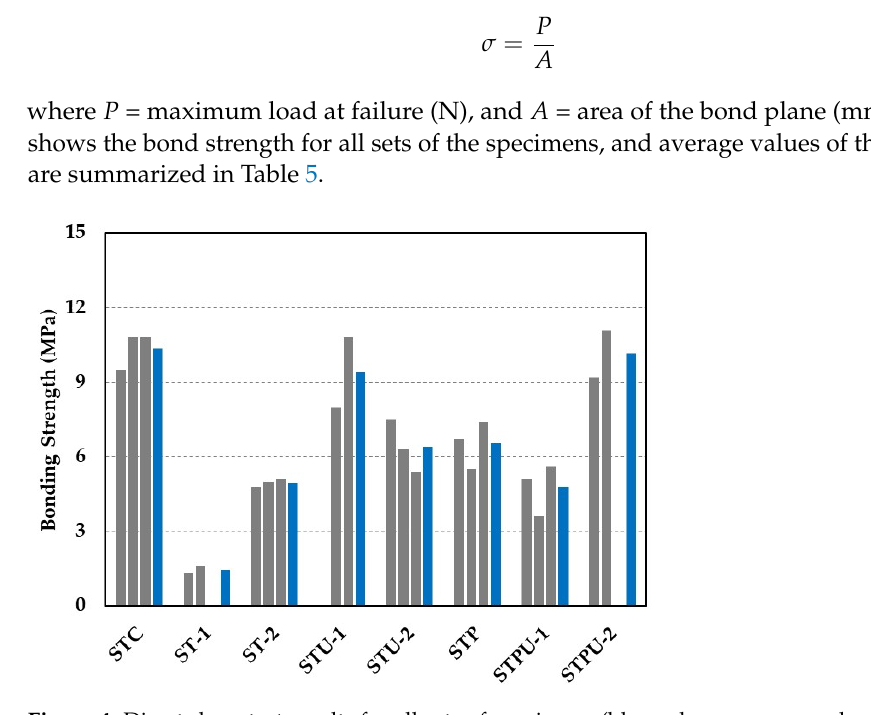
Figure 4. Direct shear test results for all sets of specimens (blue color = average value of tests). The average bond strength of concrete without repair material (STC series) is found to be 10.4 MPa. On the other hand, the average bond strength of the concrete substrate with multi-purpose grout (G1) cast and cured under dry and underwater conditions is 1.5 MPa and 5.0 MPa, respectively. The bond failure occurs at the concrete–grout interface for the ST-1 and ST-2 series specimens. The bond strength varies greatly depending on the casting and curing conditions. Although the same grout (G1) is used as a repair material, the average bond strength of the ST-1 series specimen (dry casting) is only 30% of that of the ST-2 series specimen (underwater casting and curing). Note that the grout was cast without pre-wetting of the concrete substrate for ST-1 series specimens. Therefore, mixing water from the grout might be absorbed into the concrete substrate, and this results in an adverse effect on the bond strength of the concrete–grout interface. A research group